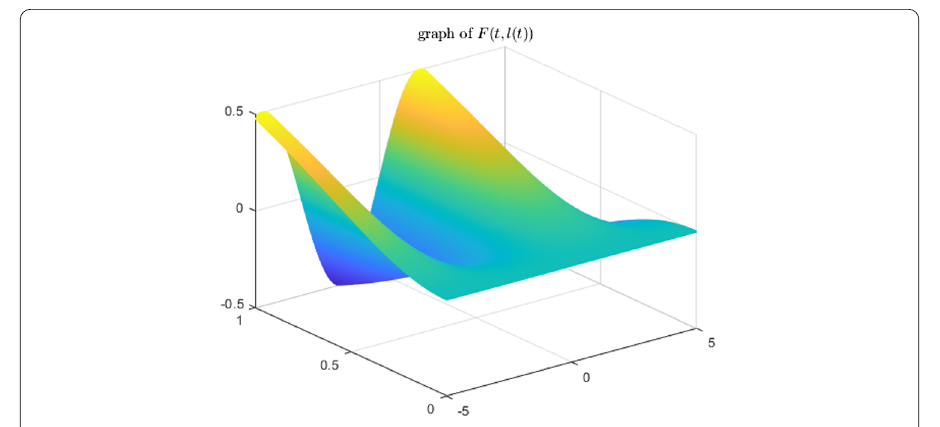
Figure 3 The graph of F ( t , l ( t ))